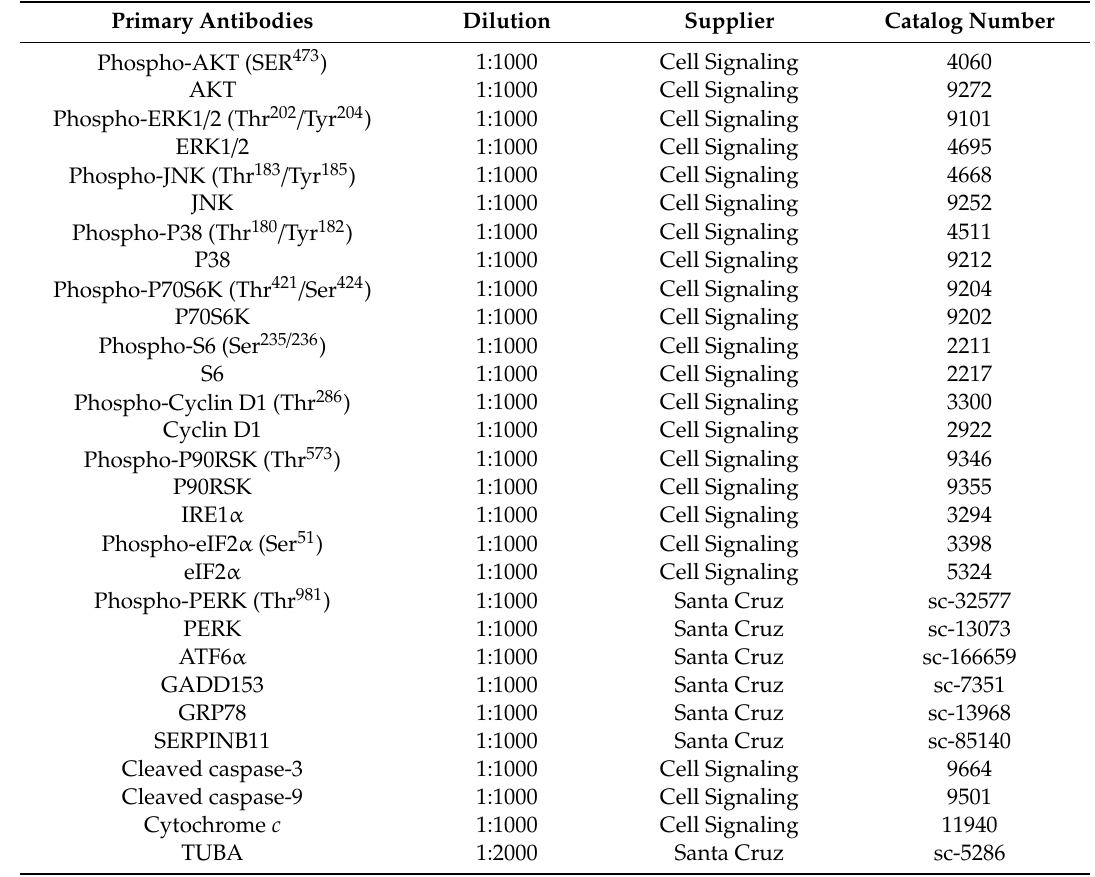
Table 1. List of primary antibodies used in the western blot